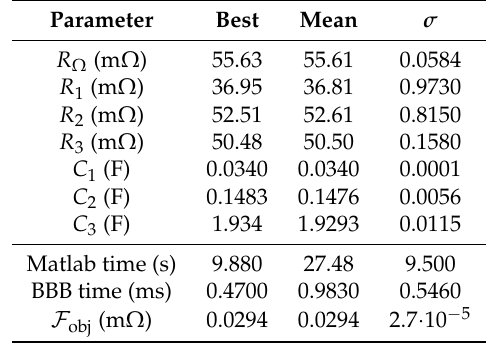
Table 3. Dataset A. EA identification results (linear model).